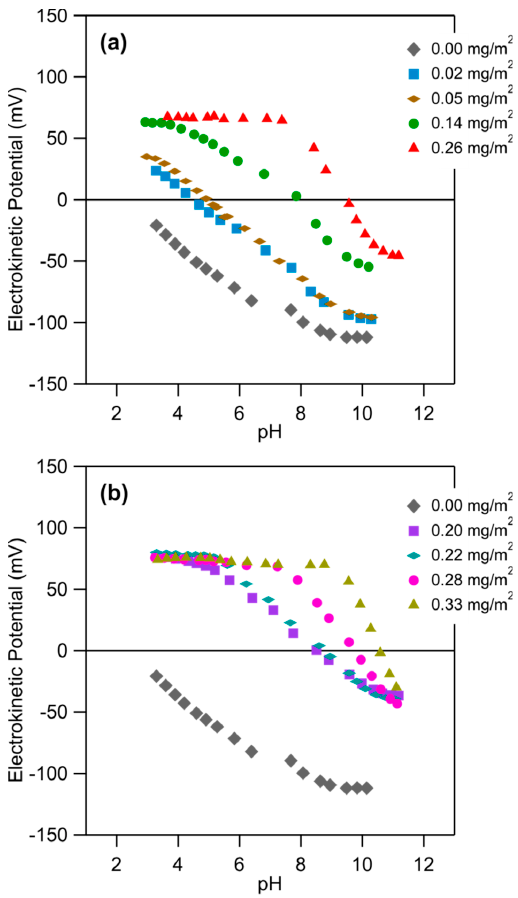
Figure 5. Electrokinetic potential of the ex situ PDADMAC-functionalized silica surfaces versus pH at an ionic strength of 1.0 mM. The substrates were functionalized in PDADMAC solutions of 5.0 mg/L for different ionic strengths at ( a ) pH 4.0 and ( b ) pH 10.0. The resulting adsorbed amount of PDADMAC is indicated.